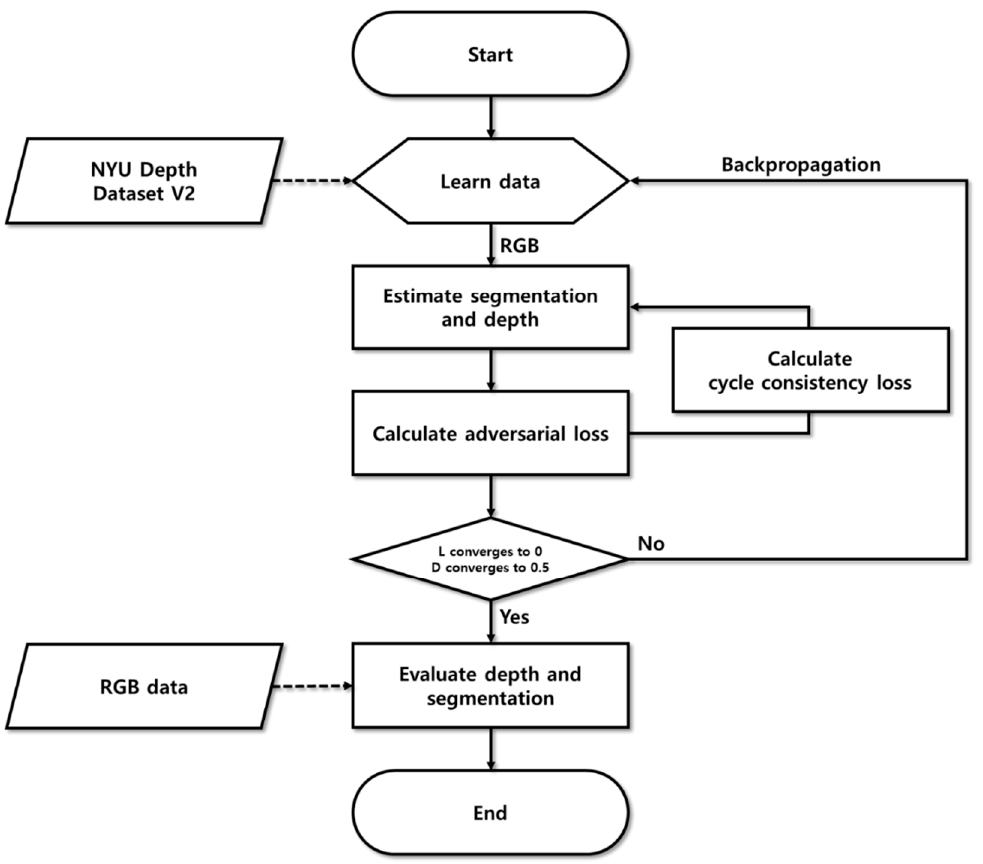
Figure 13. Experimental process.